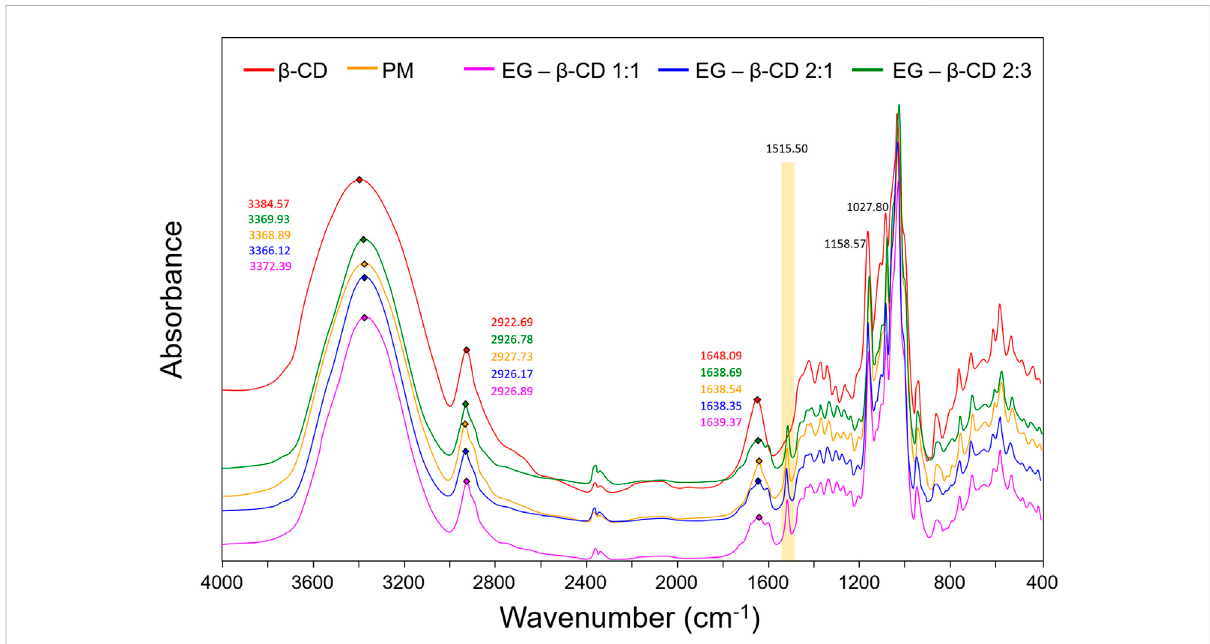
FIGURE 3 Comparison between the FTIR spectra for the β -cyclodextrin, physical mixture of eugenol and β -cyclodextrin, inclusion complex of eugenol – β -cyclodextrinina1:1ratio, inclusioncomplexofeugenol – β -cyclodextrin ina2:1ratio, andinclusioncomplexofeugenol – β -cyclodextrin in a 2:3